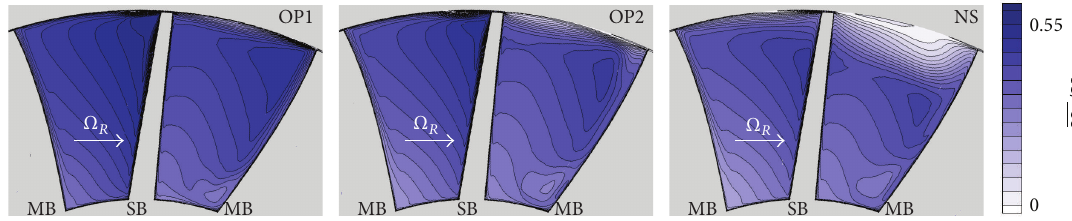
Figure 7: Time-averaged reduced meridional velocity contours at section B, for the three operating points.